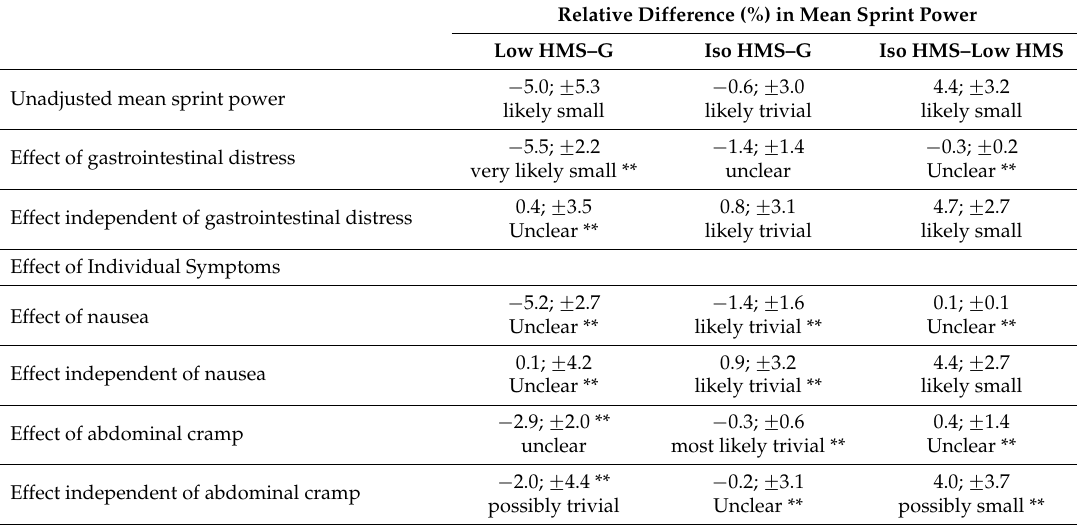
Table 3. Effect of gastrointestinal distress on mean sprint